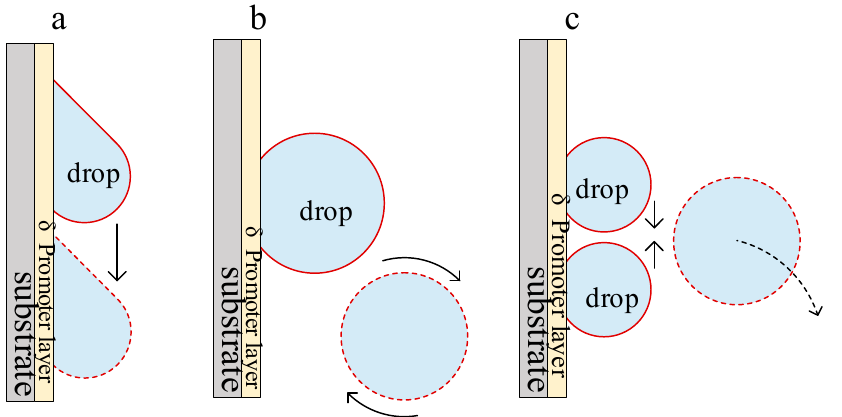
Figure 2. Schematic diagram of three different droplet departure modes: ( a ) sliding; ( b ) rolling; ( c ) jumping.